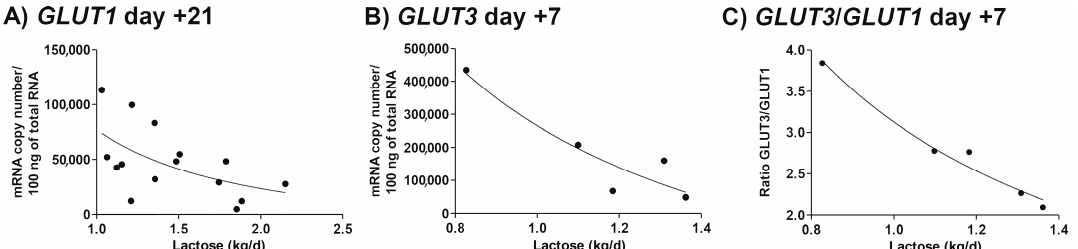
Figure 3. Peripartal monocyte glucose transporter expression is correlated with lactose production. glucose transporter 1 (GLUT1) ( A ) and GLUT3 ( B ) mRNA expression as well as the GLUT3 / GLUT1 ratio ( C ) at d + 7 and d + 21 relative to parturition were correlated with milk production data of wk 1 ( n = 5) and wk 3 ( n = 15) of lactation, respectively, using Pearson (GLUT1 and GLUT3 / GLUT1) or Spearman (GLUT3) correlation. Significant correlations with lactose production (at least p < 0.05, r > − 0.50) were followed by nonlinear regression analysis (inverse model: Y = B0 + B1 / X). ( A ) GLUT1 d + 21 (R 2 = 0.314, B0 = − 30,557, B1 = 107,794), ( B ) GLUT3 d + 7 (R 2 = 0.871, B0 = − 495,507, B1 = 761,265), and ( C ) GLUT3 / GLUT1 ratio d + 7 (R 2 = 0.975, B0 = − 0.432, B1 = 3.549). Reprinted from Eger et al. (2016), Copyright (2016) with permission from Elsevier.